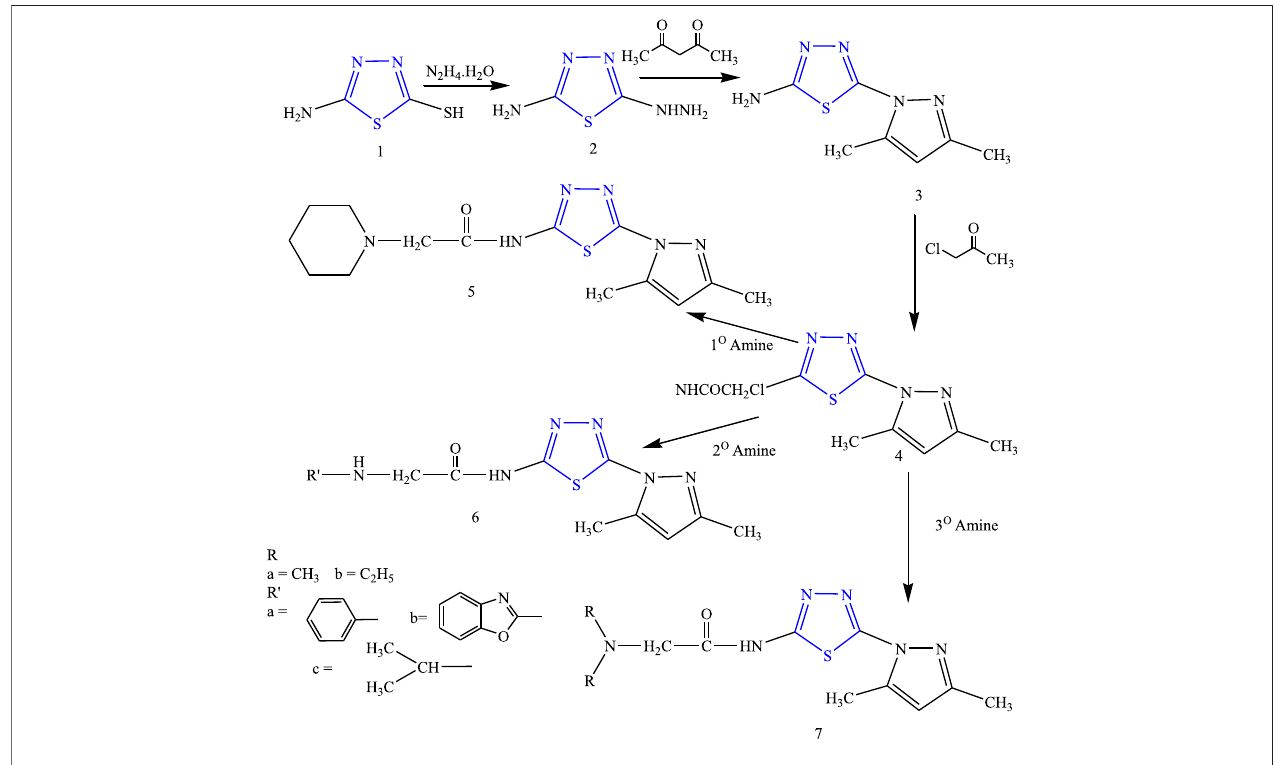
FIGURE 12 | Synthetic pathway for designing amide 1,3,4-thiadiazole derivatives.